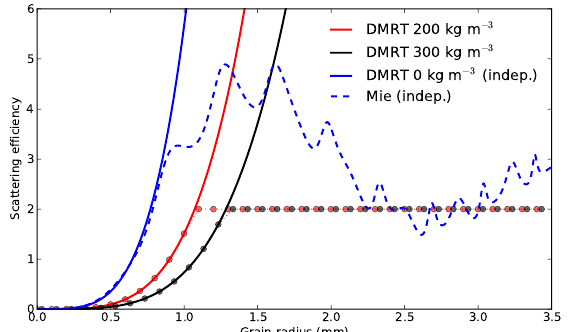
Fig. 4. Scattering efficiency ( Q s = 4 aκ s / 3 f ) at 89GHz as a func- tion of the grain size for different approximations and densities: Independent scattering approximation (applies for very small den- sity only) using DMRT-ML with a density approaching 0 (solid blue line), or full Mie calculation (dashed blue line); DMRT-ML QCA-CP nonsticky with a density of 200kgm − 3 (solid red line) and 300kgm − 3 (solid black line). Dotted curves show calculations based on the DMRT-ML theory with a limitation of the scattering efficiency at Q s = 2, for two different densities. 41